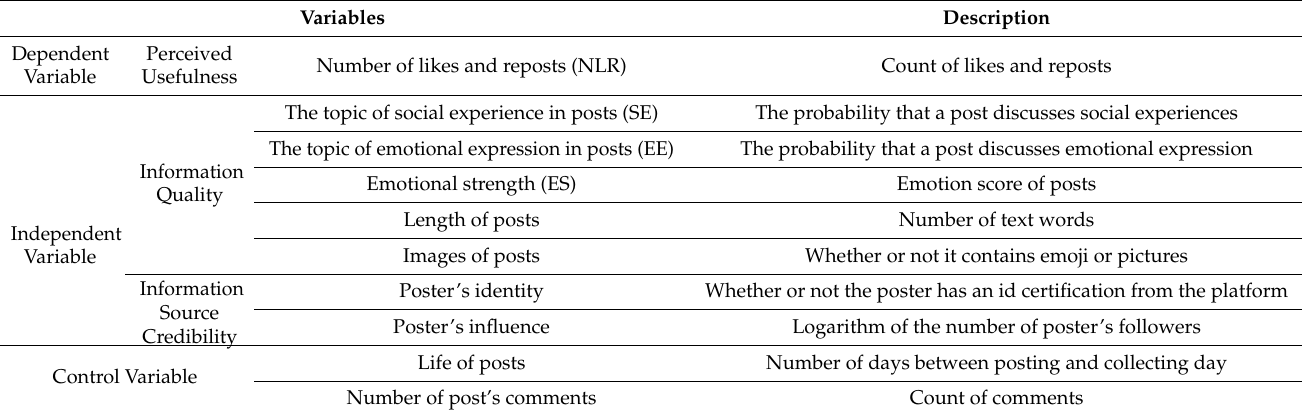
Table 1. The definitions and descriptions of the